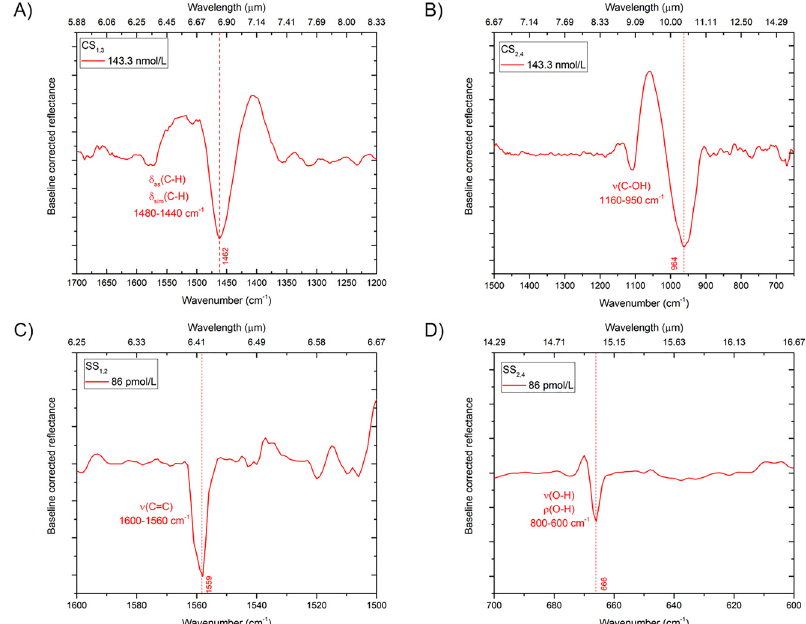
Figure 7: Baseline-corrected reflectance spectra pertaining to representative